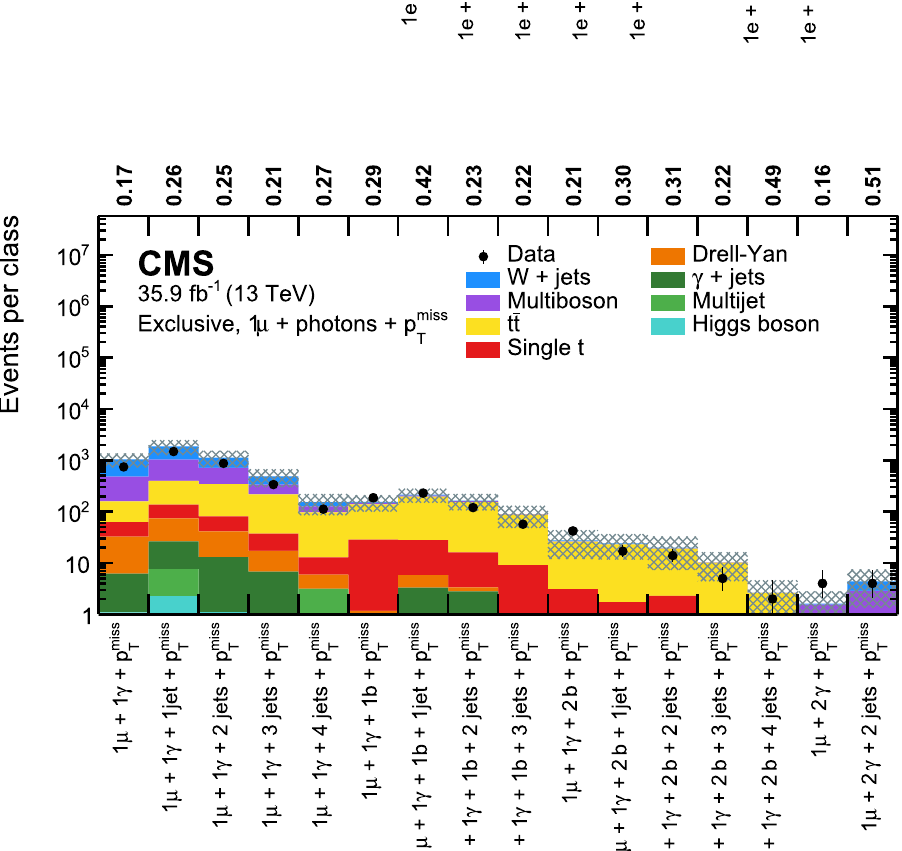
Fig. 19 Overview of total event yields for the event classes of the single-electron + photons + p miss (upper) and the T single-muon + photons + p miss T (lower) object groups. Measured data are shown as black markers, contributions from SM processes are represented by coloured histograms, and the shaded region represents the uncertainty in the SM background. The numbers above the plot indicate the observed p value for the agreement of data and